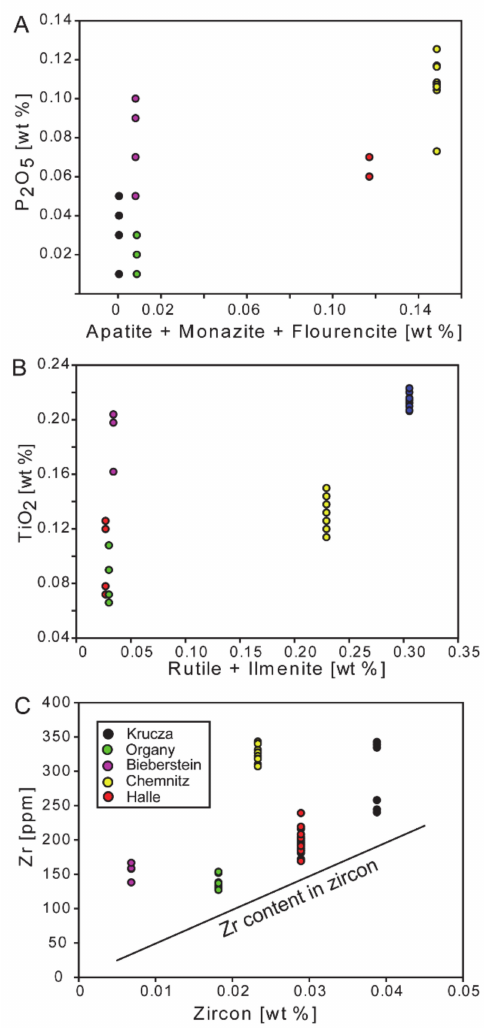
Figure 8. Comparison of modal proportions of zircon and other accessory minerals (from MLA) with whole rock compositions for the major constituents of these minerals: ( A ) phosphorous-bearing minerals, ( B ) titanium-bearing minerals ( C) zircon . The solid line in the zircon diagram (C) is the expected Zr concentration in whole rock assuming that all Zr is in zircon and Zr content in zircon is the average taken from Słodczyk et al.